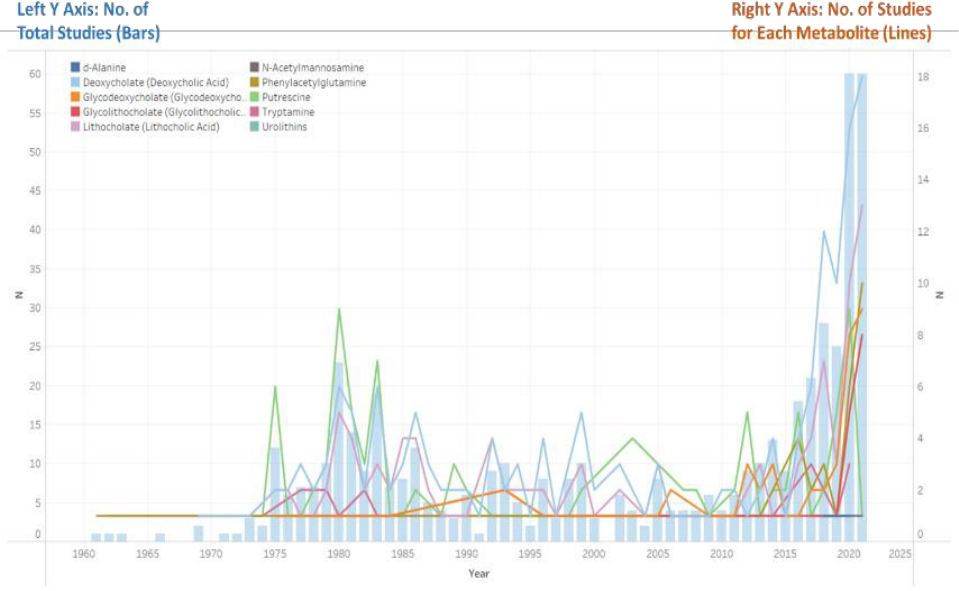
Figure 2. Publishing Year of Included Studies. Note: A study may be counted multiple times if it assesses multiple metabolites.